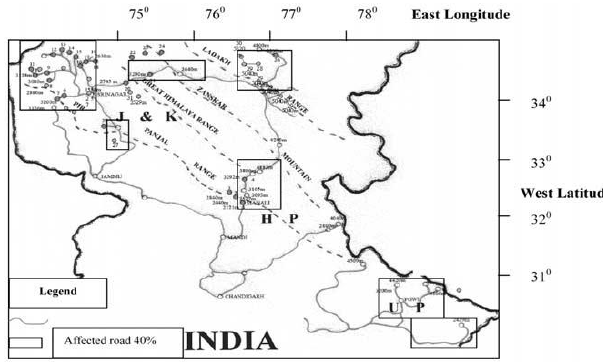
Figure 1 Snow avalanche hazards areas in North-West India (Ganju & Damari, 2004).